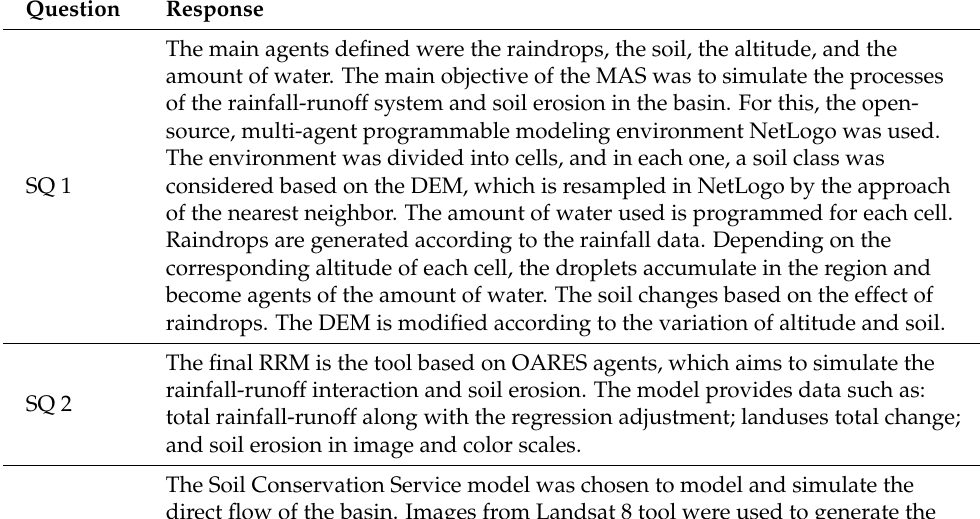
Table A5. Answers of specific questions about the work of Majumdar et al.